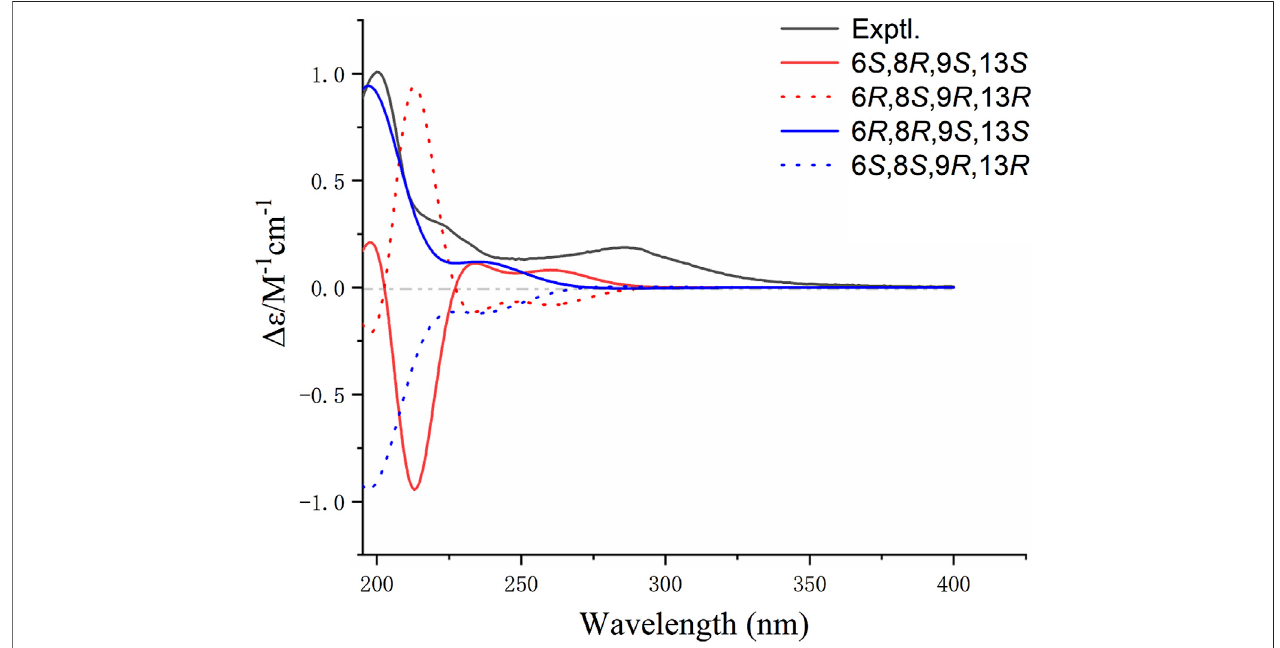
FIGURE 3 | Experimental and calculated ECD spectra of compound 1 .